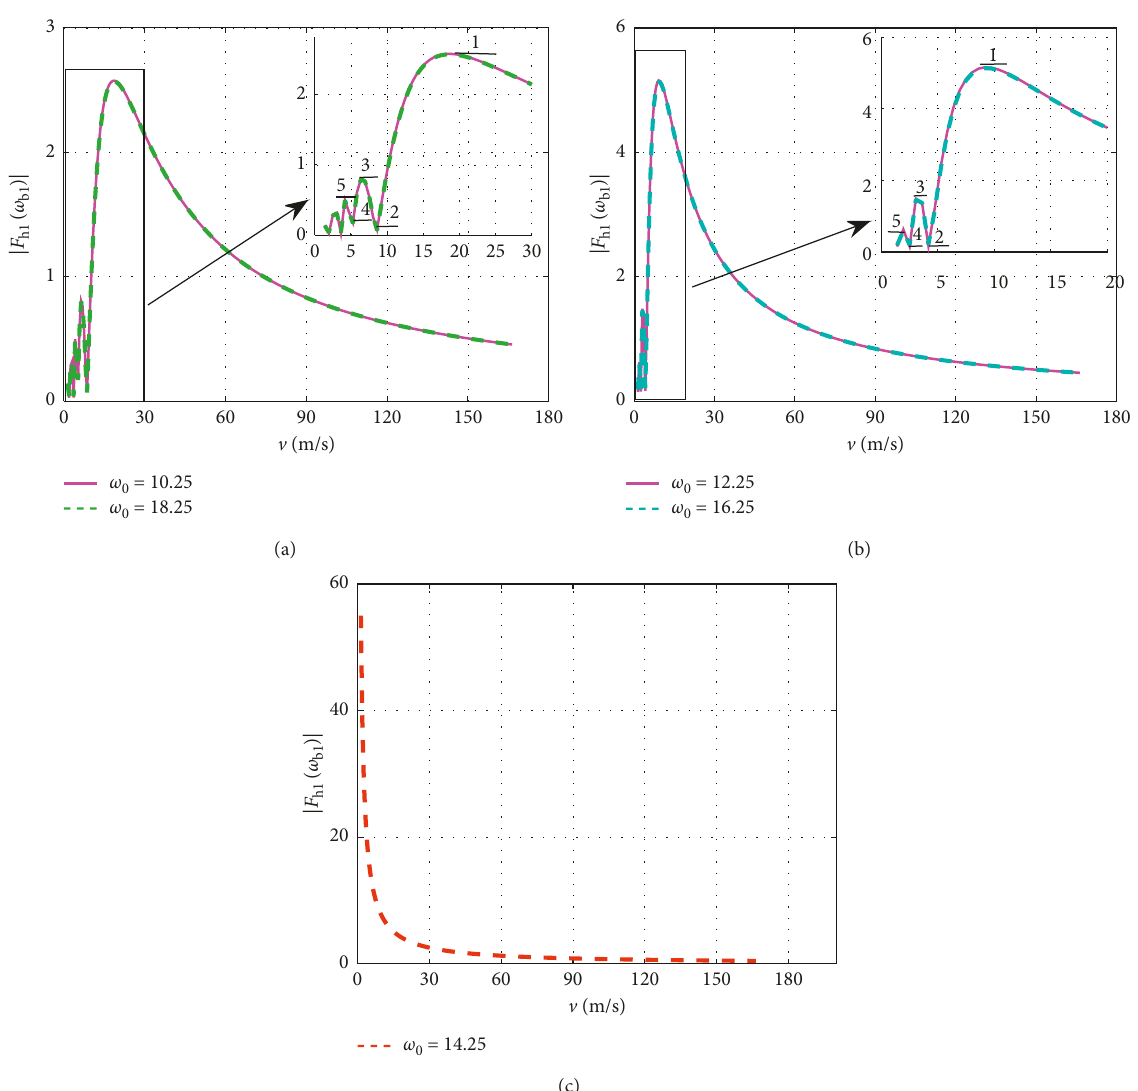
Figure 13: Amplitudes of the moving harmonic loads with different frequencies versus different